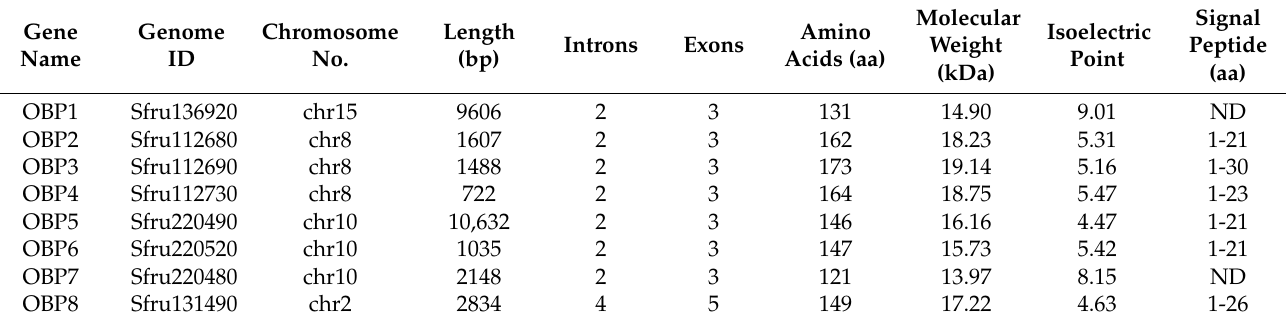
Table 1. Physical and molecular properties of 33 SfruOBPs identified in the Fall armyworm ( S. frugiperda ). ND: not